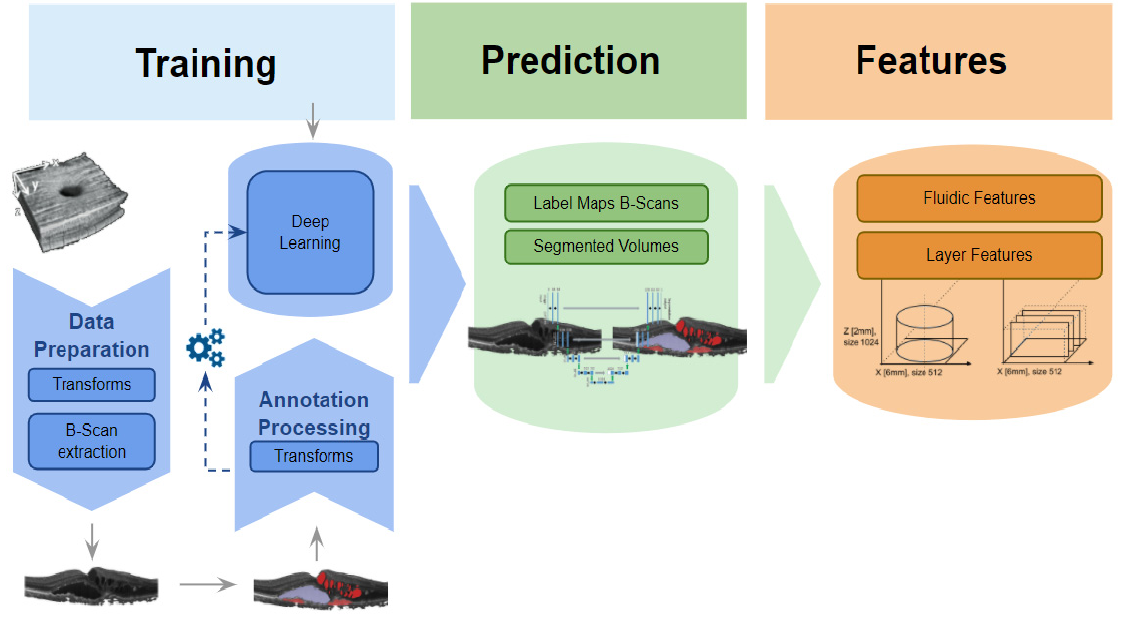
Figure 2. Segmentation pipeline. Sketch of the segmentation pipeline, involving training, prediction, and feature calculation for both fluidic and layer features. See Supplementary Table S2 for a detailed feature list.